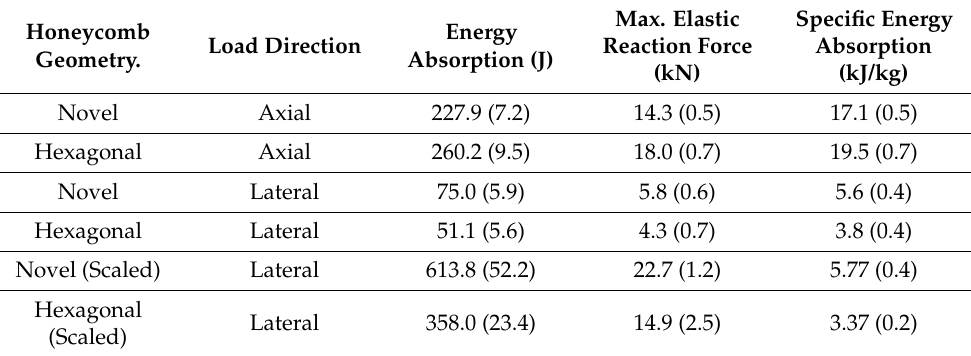
Table 5. Average values and standard deviations of the experimentally measured energy absorption, maximum reaction force at the initial elastic peak, and energy absorption per unit mass for the novel geometry and hexagonal geometry, under both axial and lateral load for the regular scale and under lateral load for the large